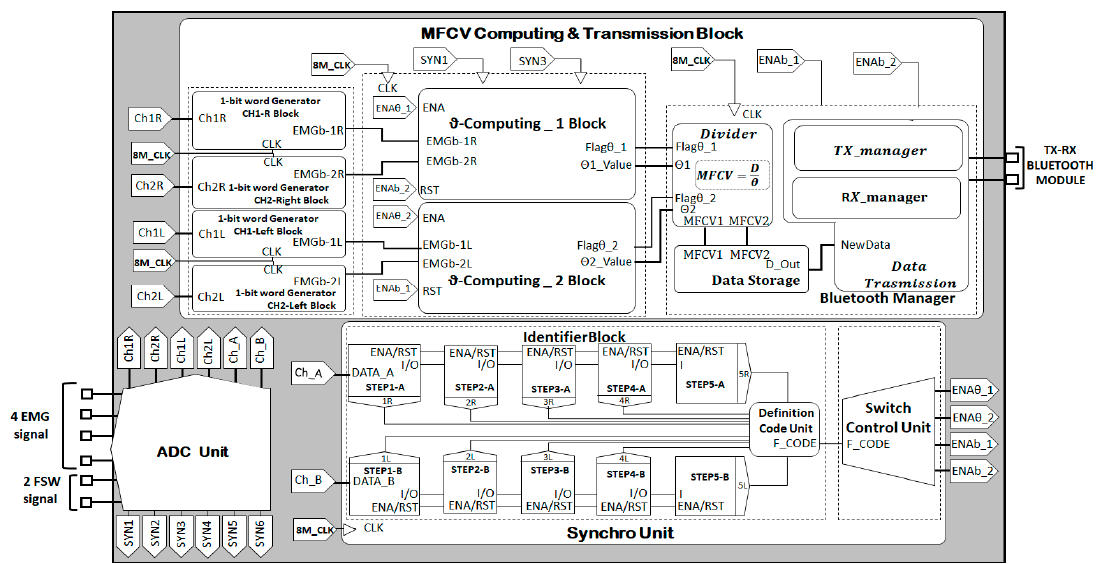
Figure 4. Block diagram of the muscle fiber conduction velocity (MFCV) estimator FPGA design.